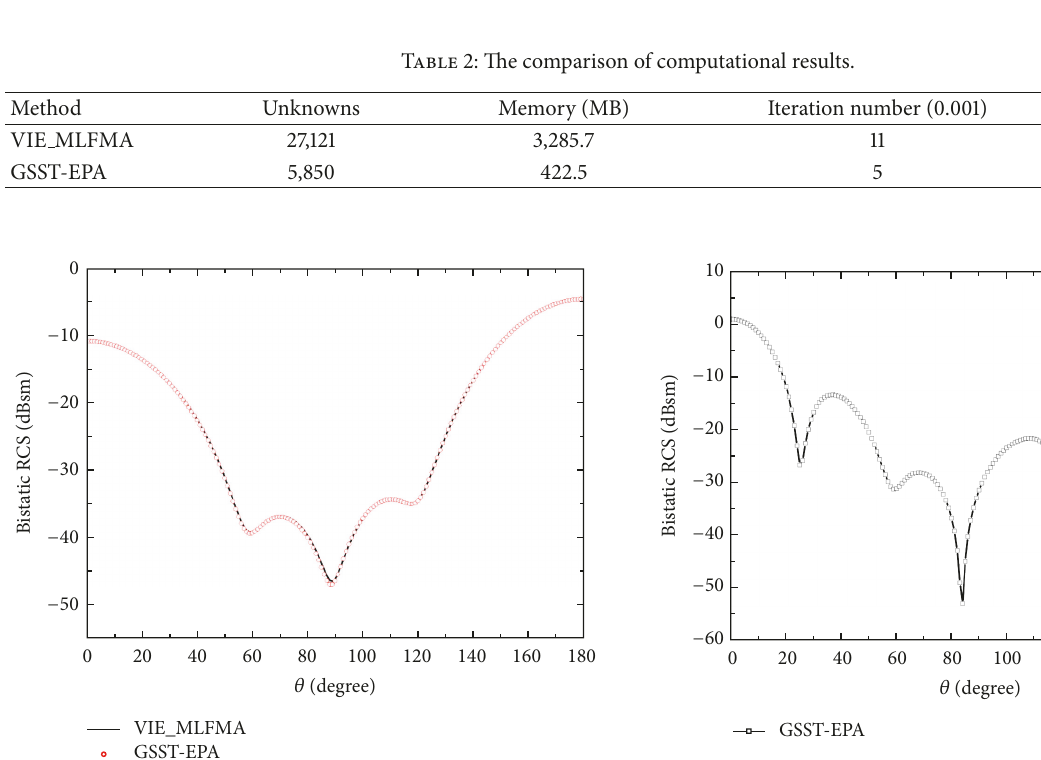
Figure 14: The bistatic RCS of 10 × 10 pyramid array; HH polarization at